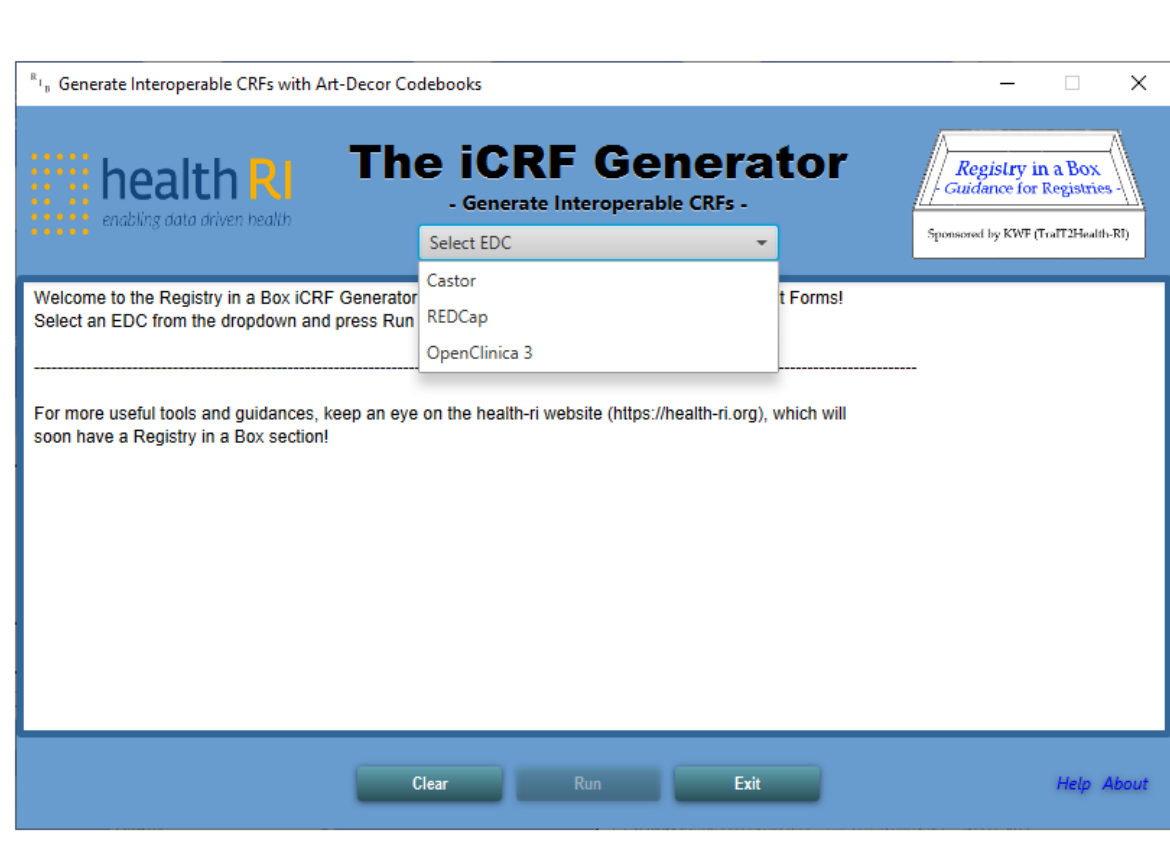
Figure 2. User selects an electronic data capture system (EDC) from the dropdown.